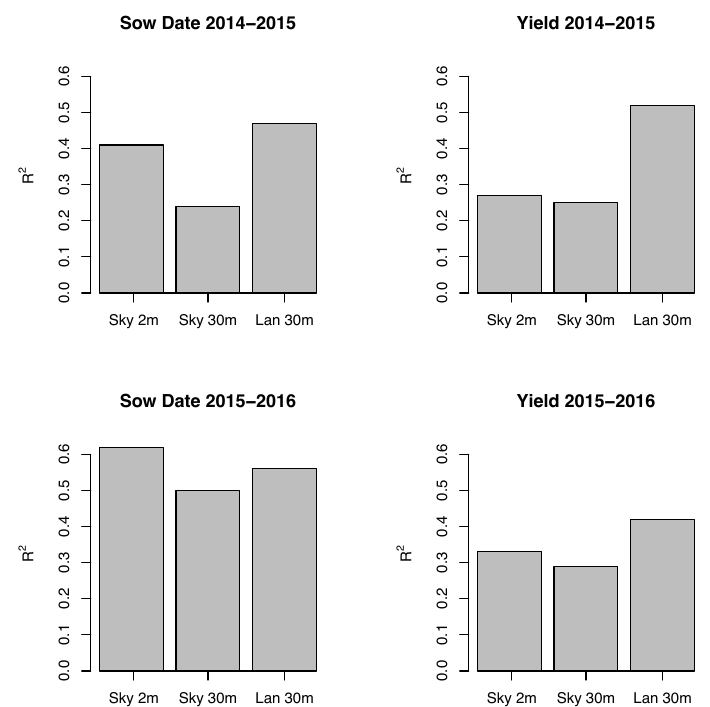
Figure 8. R 2 for all-date models predicting sow date ( A ) and yield ( B ) in 2014–2015 and sow date ( C ) and yield ( D ) in 2015–2016 using either the original SkySat data (Sky 2 m), SkySat data resampled to 30 m (Sky 30 m), or Landsat data (Lan 30 m). Five images are used for all SkySat analyses, while seven are used for Landsat analyses.